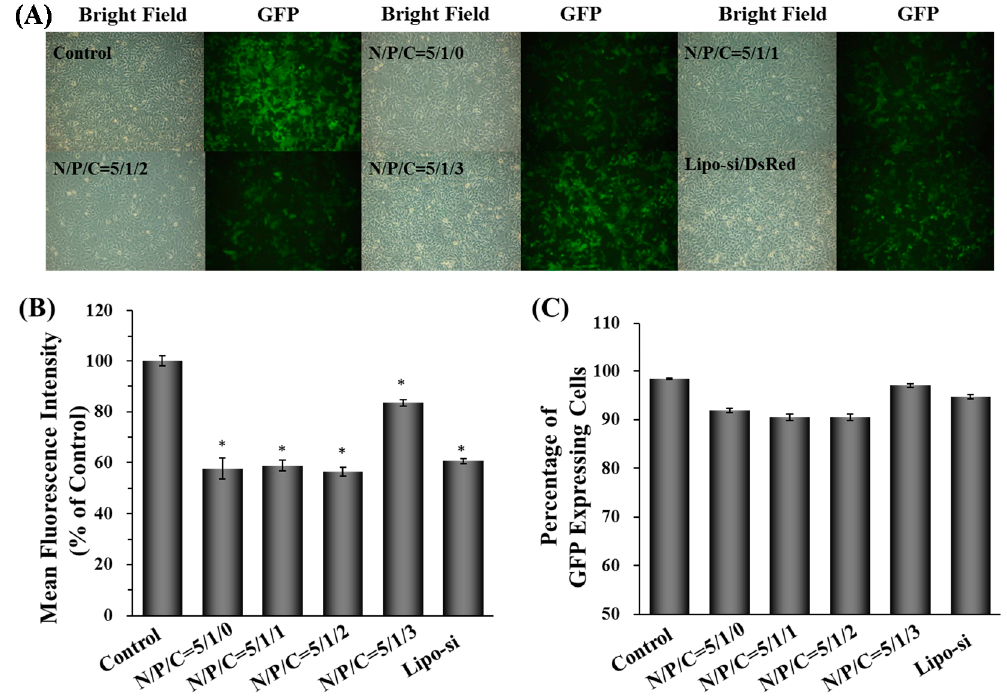
Figure 7. The gene silencing ability of γ -DDNPs. The GFP expressing-Hep 3B cells transfected with γ -DDNPs with different N/P/C ratios for 48 h. The fluorescent cellular images were taken after 48 h transfection with γ -DDNPs at different N/P/C ratios ( A ). The fluorescence intensity ( B ) and the percentage of fluorescence-expressing cells ( C ) after 48 h transfection with γ -DDNPs at different N/P/C ratios were examined by flow cytometry. The control group denotes the group of cells without any treatment. Lipo-si group means the GFP-siRNA transfection by Lipofectamine 2000. * p < 0.05, significant difference between the test group and the control group as analyzed by Student’s t test.